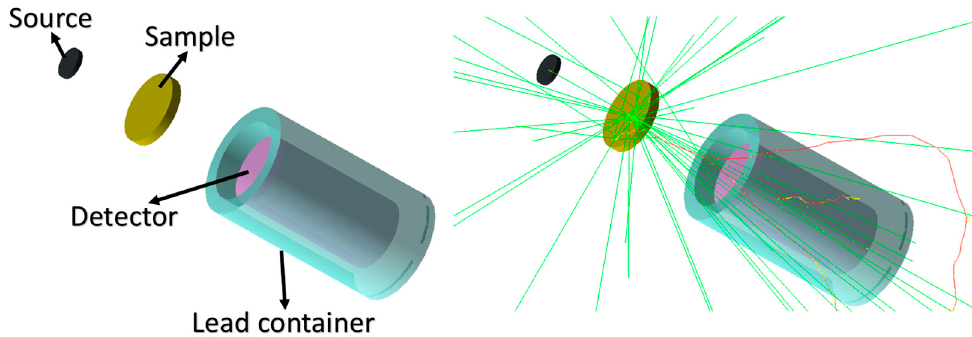
Figure 2. Geant4 simulation code setup.